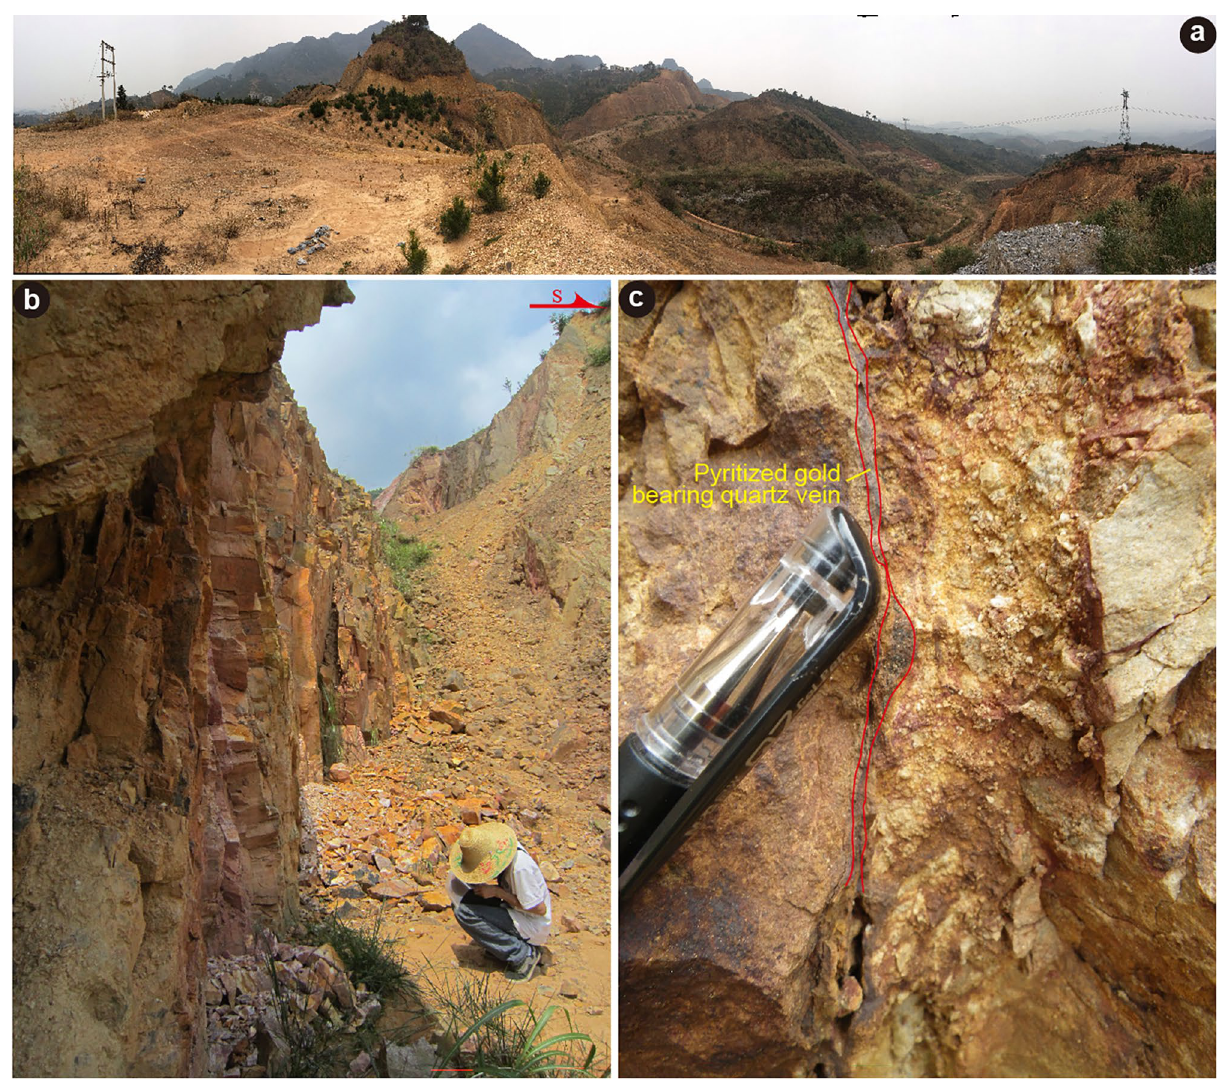
Figure 2. ( a ) Panoramic photo of Liaotun gold deposit, ( b ) goaf of ore body IV; ( c ) pyritization in an Au-bearing quartz vein in Permian quartz sandstone. Gold-bearing minerals include arsenian pyrite,